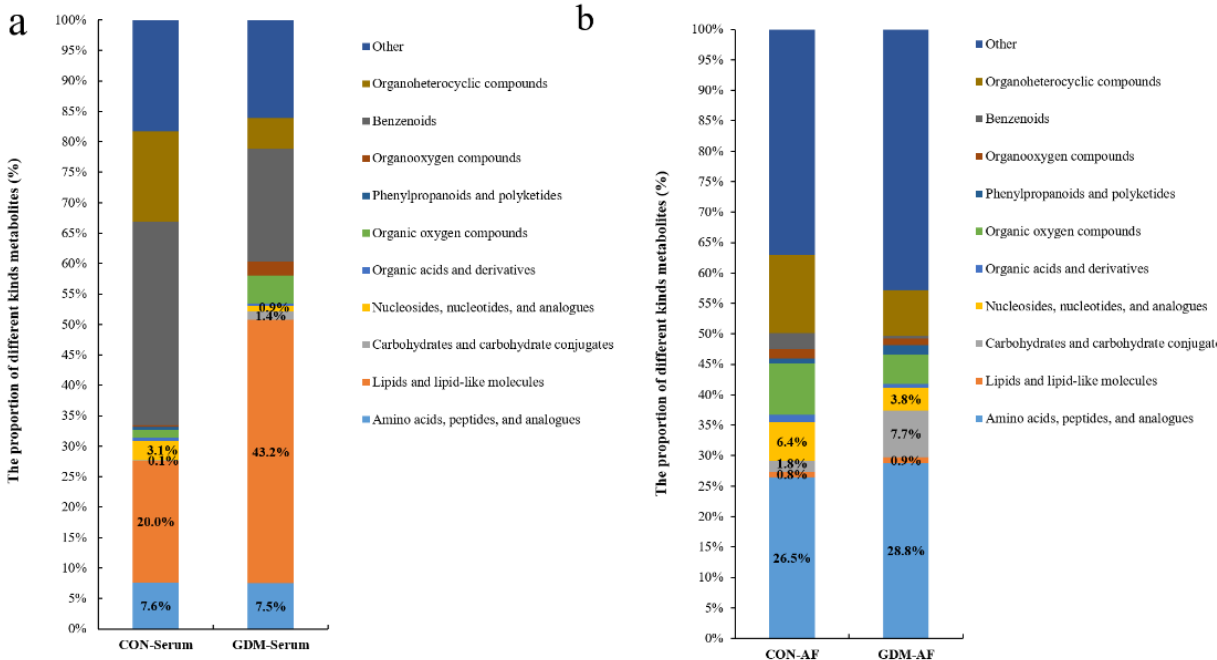
Figure 3. The proportion of differential metabolites in serum and AF samples from CON and GDM. ( a ) The proportion of differential metabolites in serum or AF samples. ( b ) The proportion of differential metabolites in AF samples. CON-serum: serum samples in CON group; GDM-serum: serum samples in GDM group; CON-AF: AF samples in CON group; GDM-AF: AF samples in GDM group; AF: amniotic fluid.